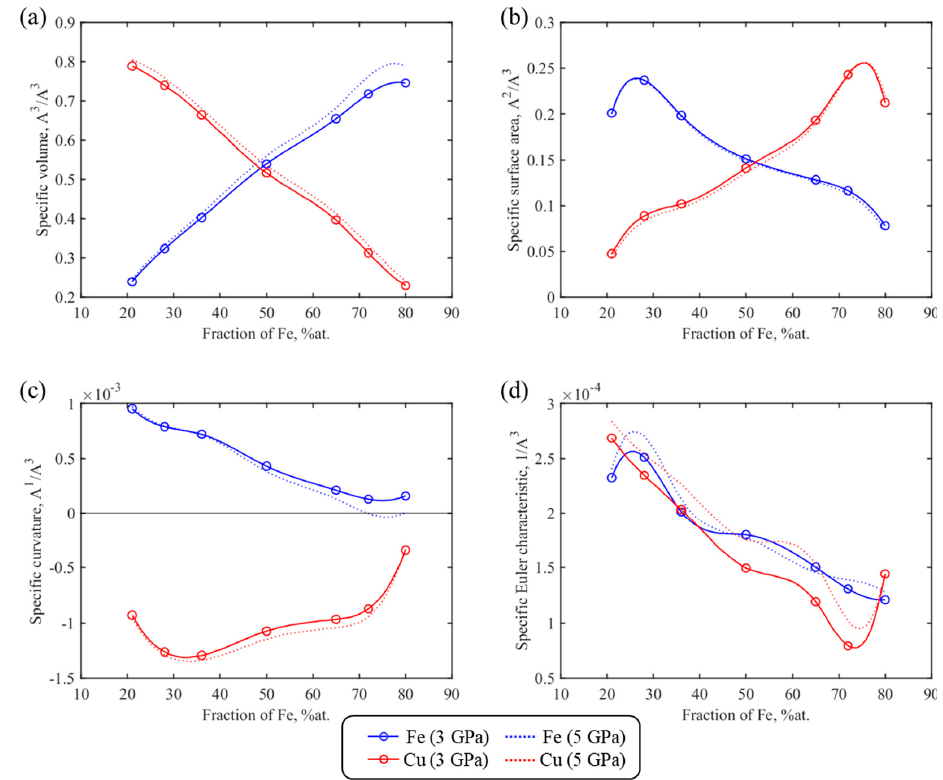
Figure 8. Four Minkowski functionals for Fe (blue) and Cu (red) phases as a function of Fe fraction in cold ‐ sintered samples M 0 ( a ), M 1 ( b ), M 2 ( c ), and M 3 ( d ). The results are presented for two consolidation pressures: 3 GPa (solid lines) and 5 GPa (dotted lines).